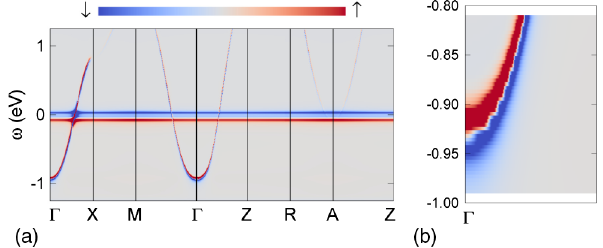
FIG. 4. Spin contrast A ↑ ð k ; ω Þ − A ↓ ð k ; ω Þ from a one-step DFT þ sicDMFT calculation with spin-polarized Ni self-energies (see text). (a) Energy window around the Fermi level. (b) Blow- up close to Γ , to extract the spin splitting of the electron